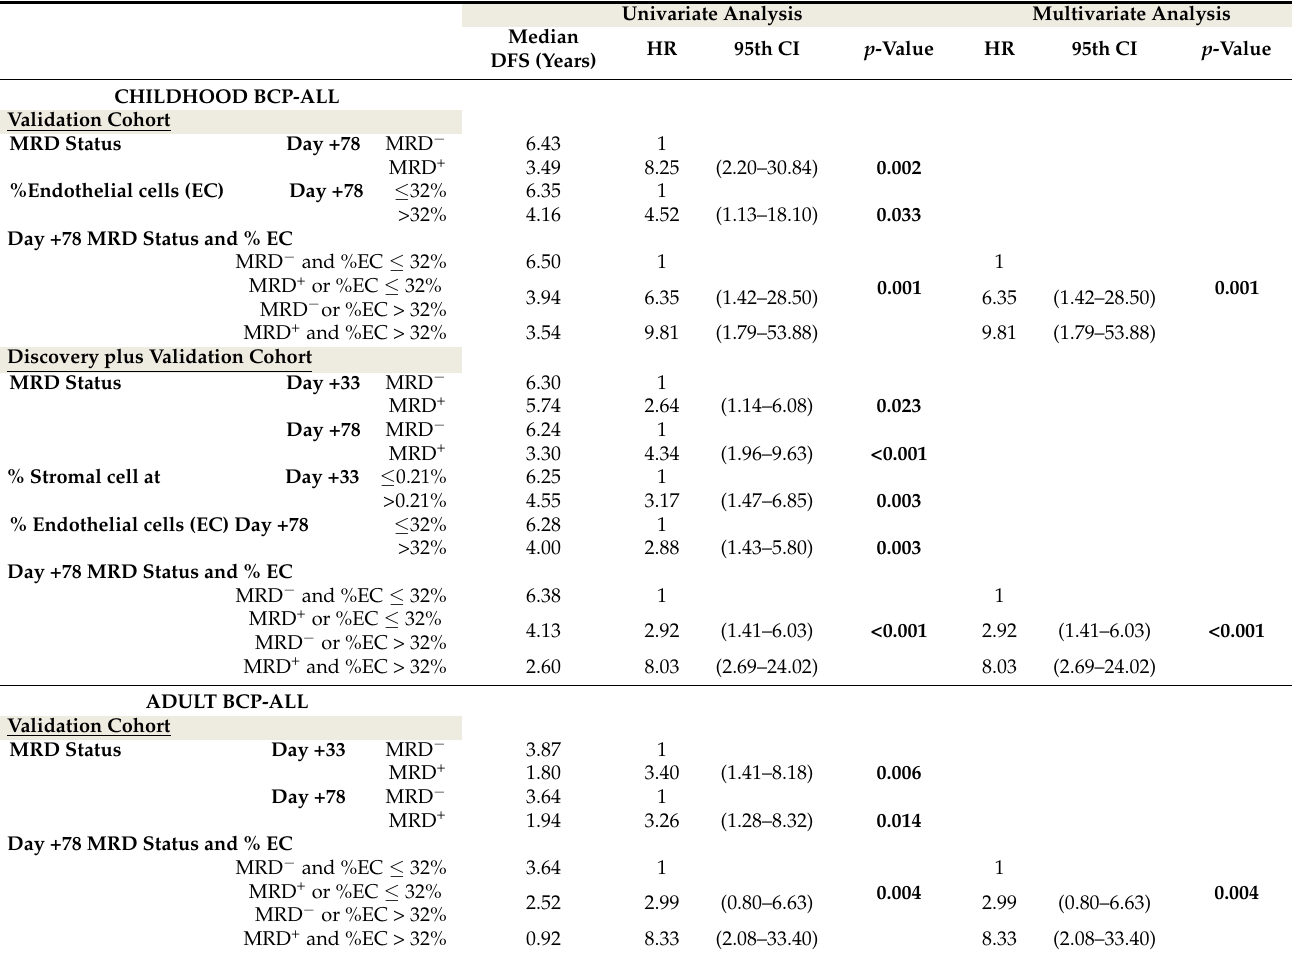
Table 3. Prognostic impact of the new BCP-ALL risk stratification model proposed for DFS of patients included in the childhood BCP-ALL validation cohort, the childhood BCP-ALL discovery + validation cohorts, and the adult BCP-ALL validation cohort. Univariate Analysis Multivariate Analysis